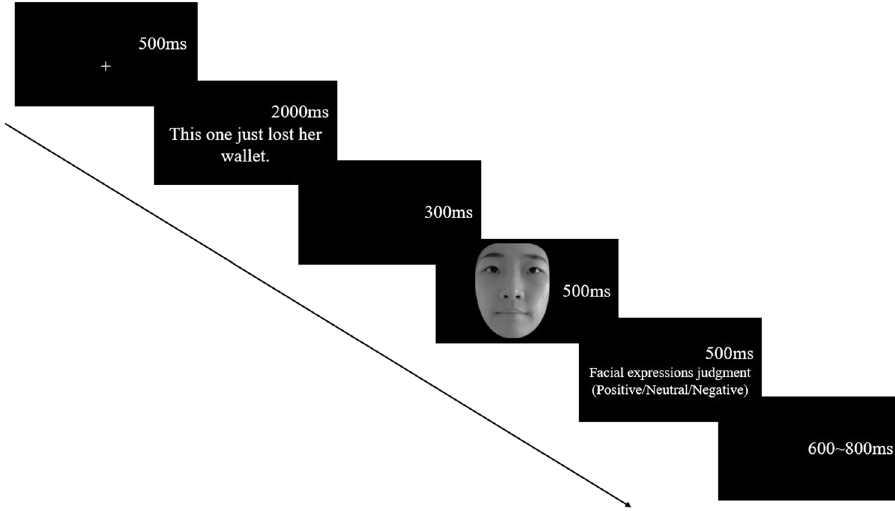
Figure 1. Timings and displays of one trial in the task. (Please reader note that due to the privacy rights, the present pictures were not the stimuli used in the experiment. The model in the sample pictures agreed to publish her pictures in the journal).